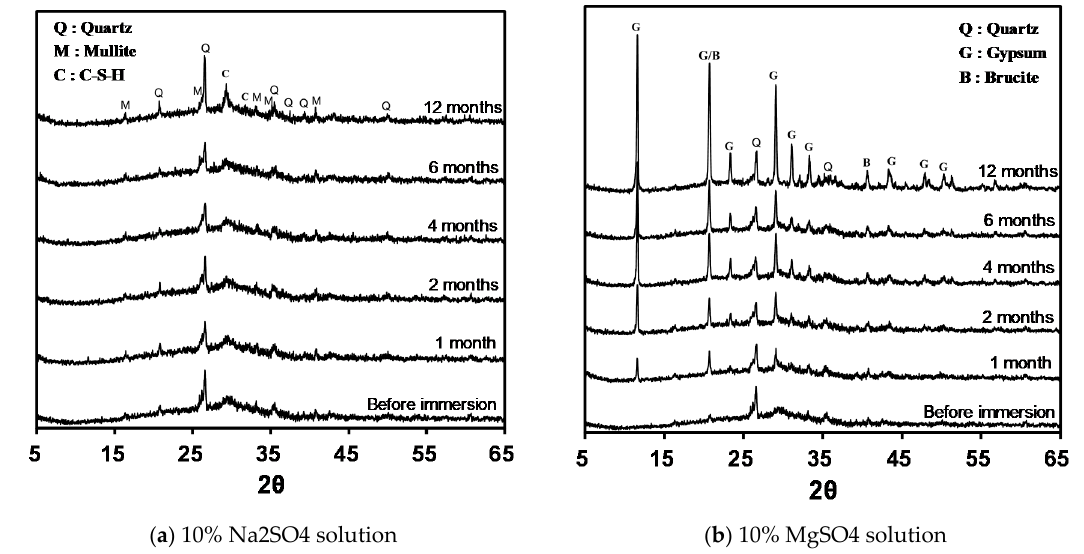
Figure 9. XRD patterns of S30-2.0-23 samples, immersed in ( a ) 10% Na 2 SO 4 solution and ( b ) 10% MgSO 4